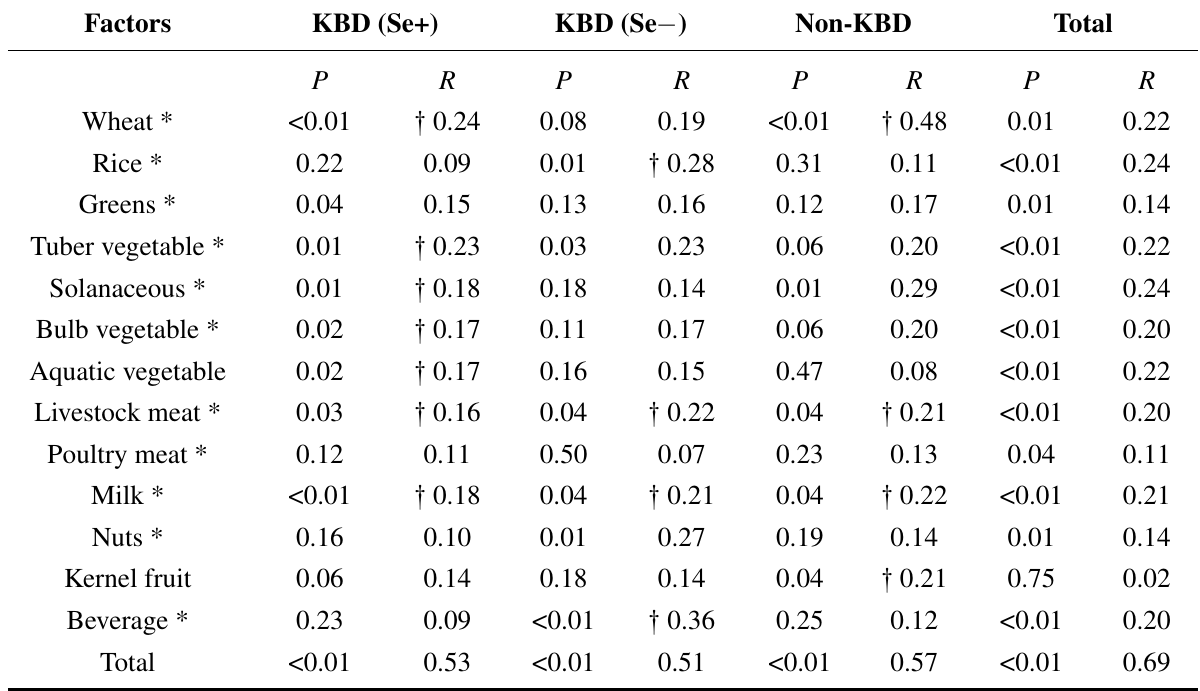
Table 4. Significant dietary factors of daily Se intakes of children without supplements identified included by multivariate regression